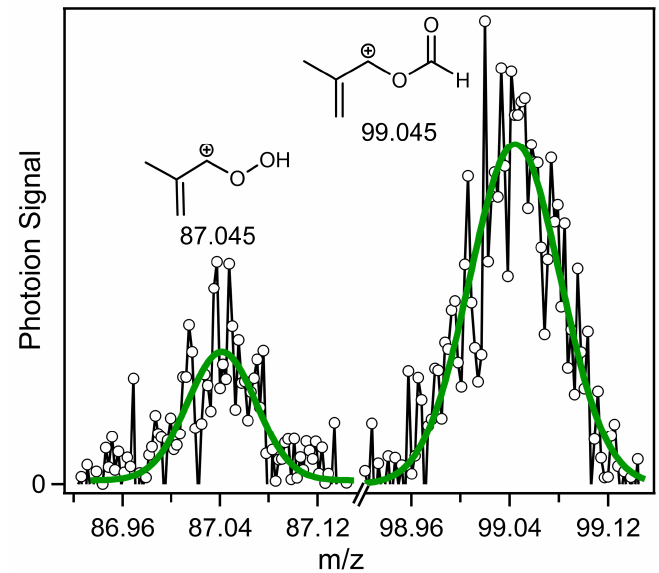
Figure 1. Fragment ions observed in the mass spectrum following the reaction of MACR-oxide with formic acid (2.6 × 10 13 cm −3 ) using MPIMS. The mass spectrum is obtained by integrating over the full kinetic time window (0–60 ms) and VUV photon energy (9.0–11.0 eV). Gaussian fits to the mass peaks yield exact masses of 87.043 ± 0.003 and 99.045 ± 0.002, consistent with the chemical composition of C 4 H 7 O 2 (87.045) and C 5 H 7 O 2 (99.045) corresponding to HCO 2 -loss and HO 2 -loss from photoionization of HPMAF, respectively.